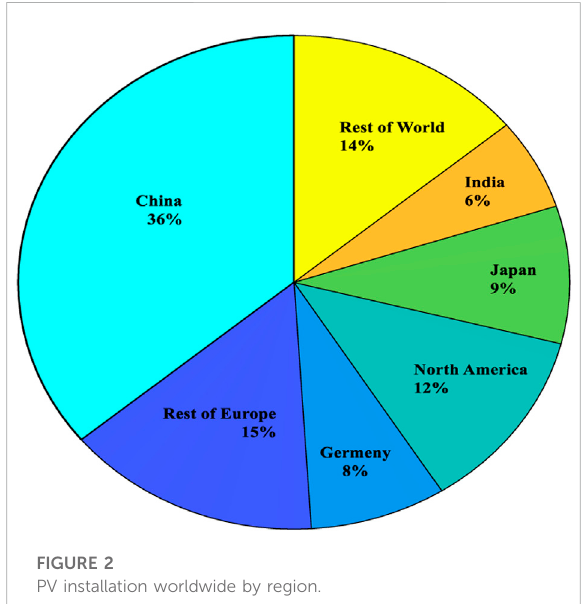
FIGURE 2 PV installation worldwide by